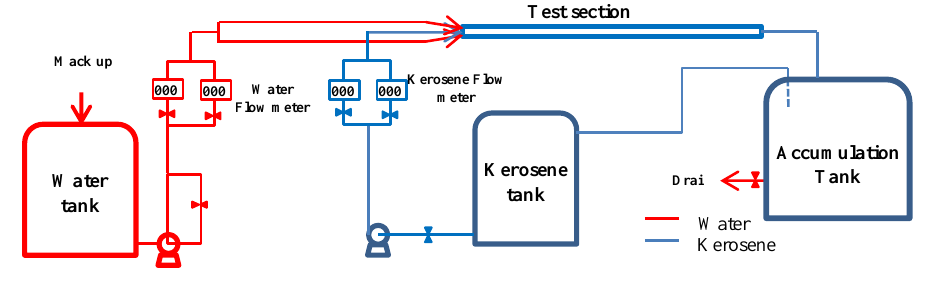
Fig. 4: The experimental rig Figure 4: The experimental rig Characteristics of pumps selected for a water pump of (120 L/min) and for oil pump of (75 L/min). Moreover, the oil and water transmitted from the tank to the test section. Kerosene was injected from the center, and the water injected from the lower and the upper layers with inclina- tion angle of 8 ∘ with respect to the horizontal axis. The two liquids were mixed at the beginning of the channel